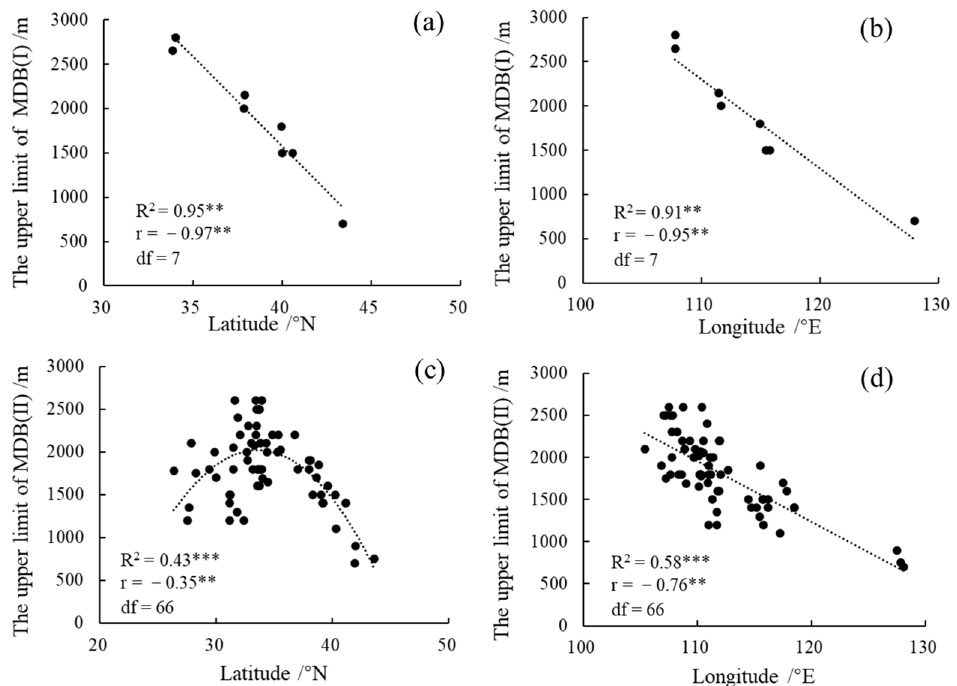
Figure 3. The relationship between the upper limit of MDB and latitude or longitude and the results of regression analysis, ( a , b , d ) linear, ( c ), curvilinear. df, degree of freedom. MDB(I), the upper limits of deciduous broad-leaved forest on the mountains with climatic treeline; MDB(II), the upper limits of deciduous broad-leaved forests on the mountains without climatic treeline. “r value” represents Pearson correlation coefficient. df, degree of freedom. Note: ** p <0.01, *** p < 0.001.